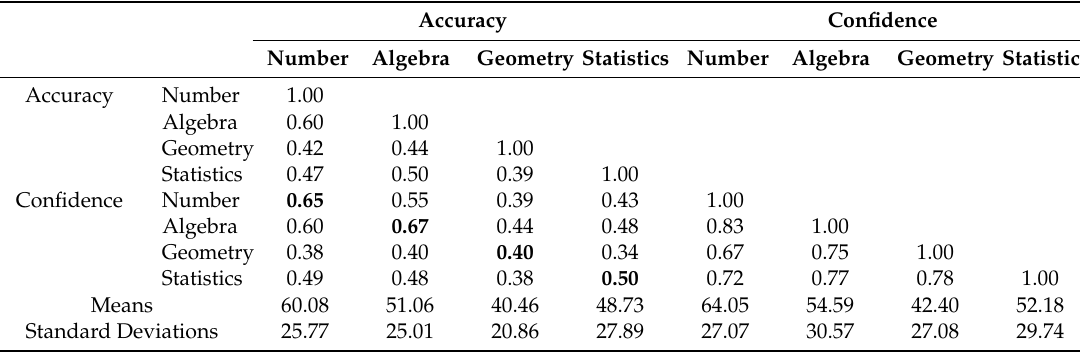
Table 3. Mathematics achievement (accuracy) and confidence correlations (N =